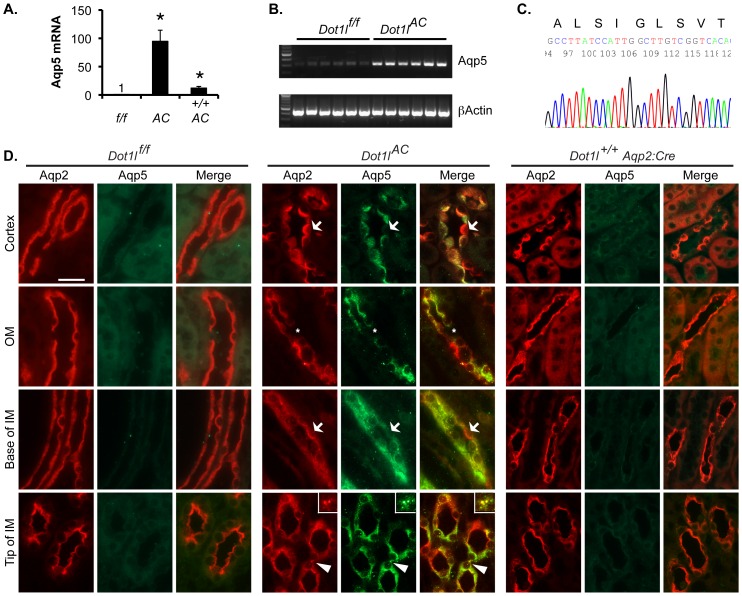
Aqp5 is significantly upregulated and coexpressed with Aqp2 in the kidney of Dot1lAC mice on the normal Na+ pellet diet.(A) Real-time RT-qPCR for expression of Aqp5 in kidney of mice fed the normal Na+ pellet diet, with β-actin as internal control. n = 6 mice/group. +/+AC: Dot1l+/+Aqp2:Cre (B) As in A, agarose gel analysis of the final RT-qPCR products of Aqp5 and β-actin. (C) Sequencing of a regular RT-PCR product from a Dot1lf/f mouse kidney. A part of the tracing file showing Aqp5 sequence encoding aa 47–55 (GenBank#: EDL04123.1) is given. (D) Representative IF images showing Aqp5 (green) expression in Aqp2+ (red) cells in mice as indicated. OM and IM: outer and inner medulla. *: An IC without Aqp5 expression, possibly due to lack of Aqp2Cre-mediated Dot1l ablation. Arrow: PC with strong Aqp2 and weak Aqp5, highlighting the lack of cross reactivity of the two antibodies. Aqp5+Aqp2− cells are most likely the intercalated cells derived from the Aqp2-expressing progenitor cells or mature PC [30]. Arrowhead: Colocalization of Aqp5 with Aqp2, which is amplified in the inserts. Scale bar: 50 µM. For more images with lower magnification, see Figure S3.